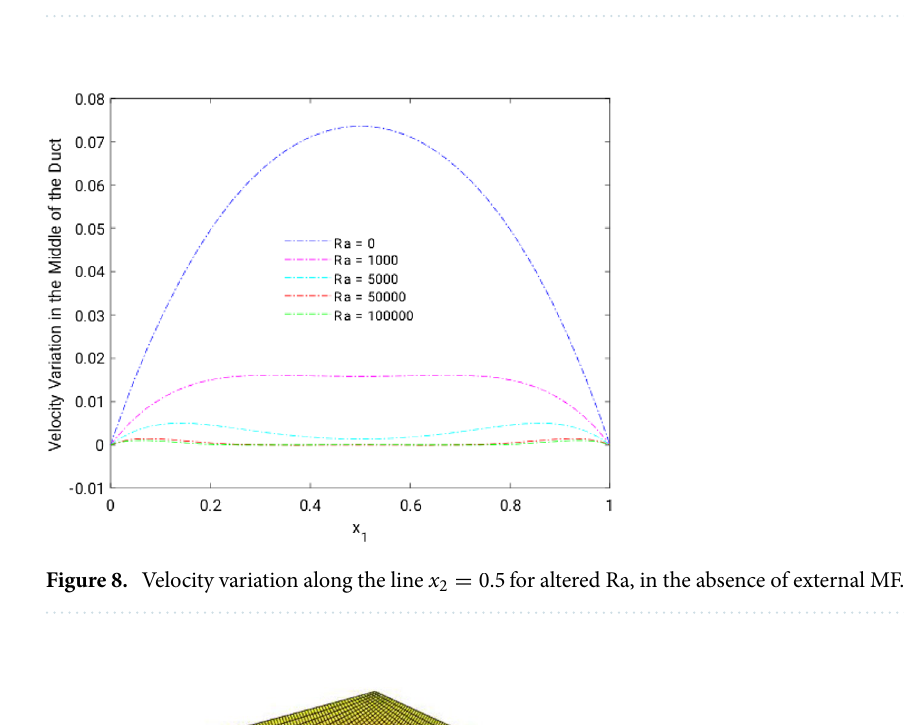
Figure 7. Velocity field for Ra = 100,000, in the absence of external MF.